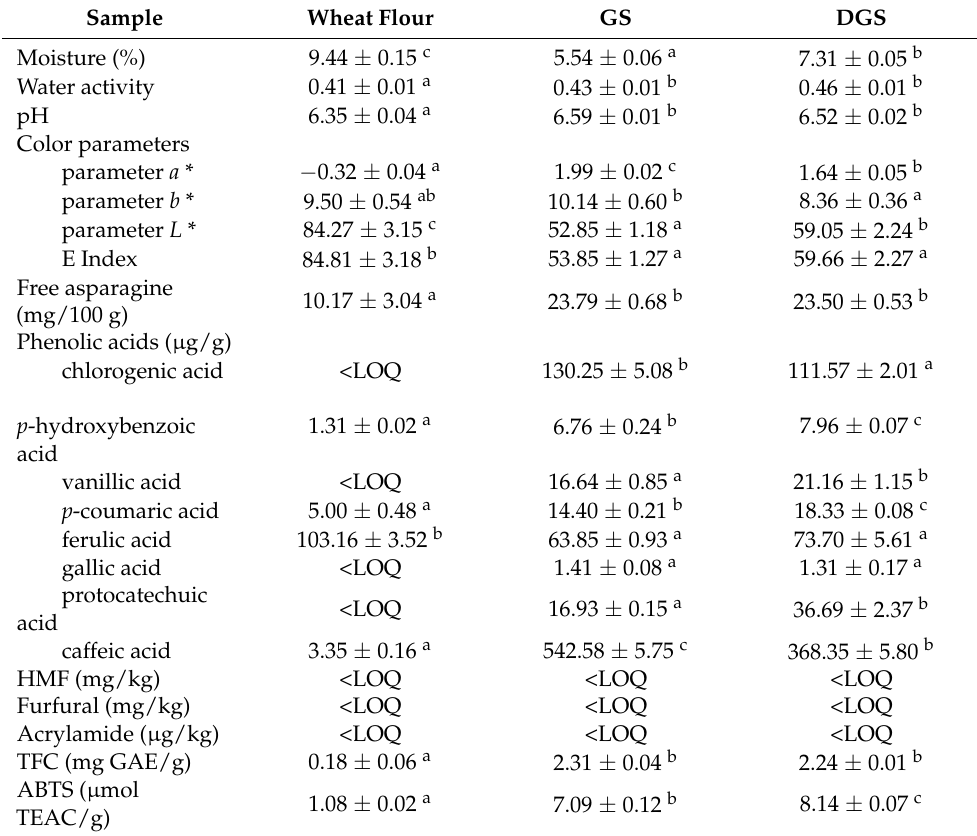
Table 3. Characterization of the raw